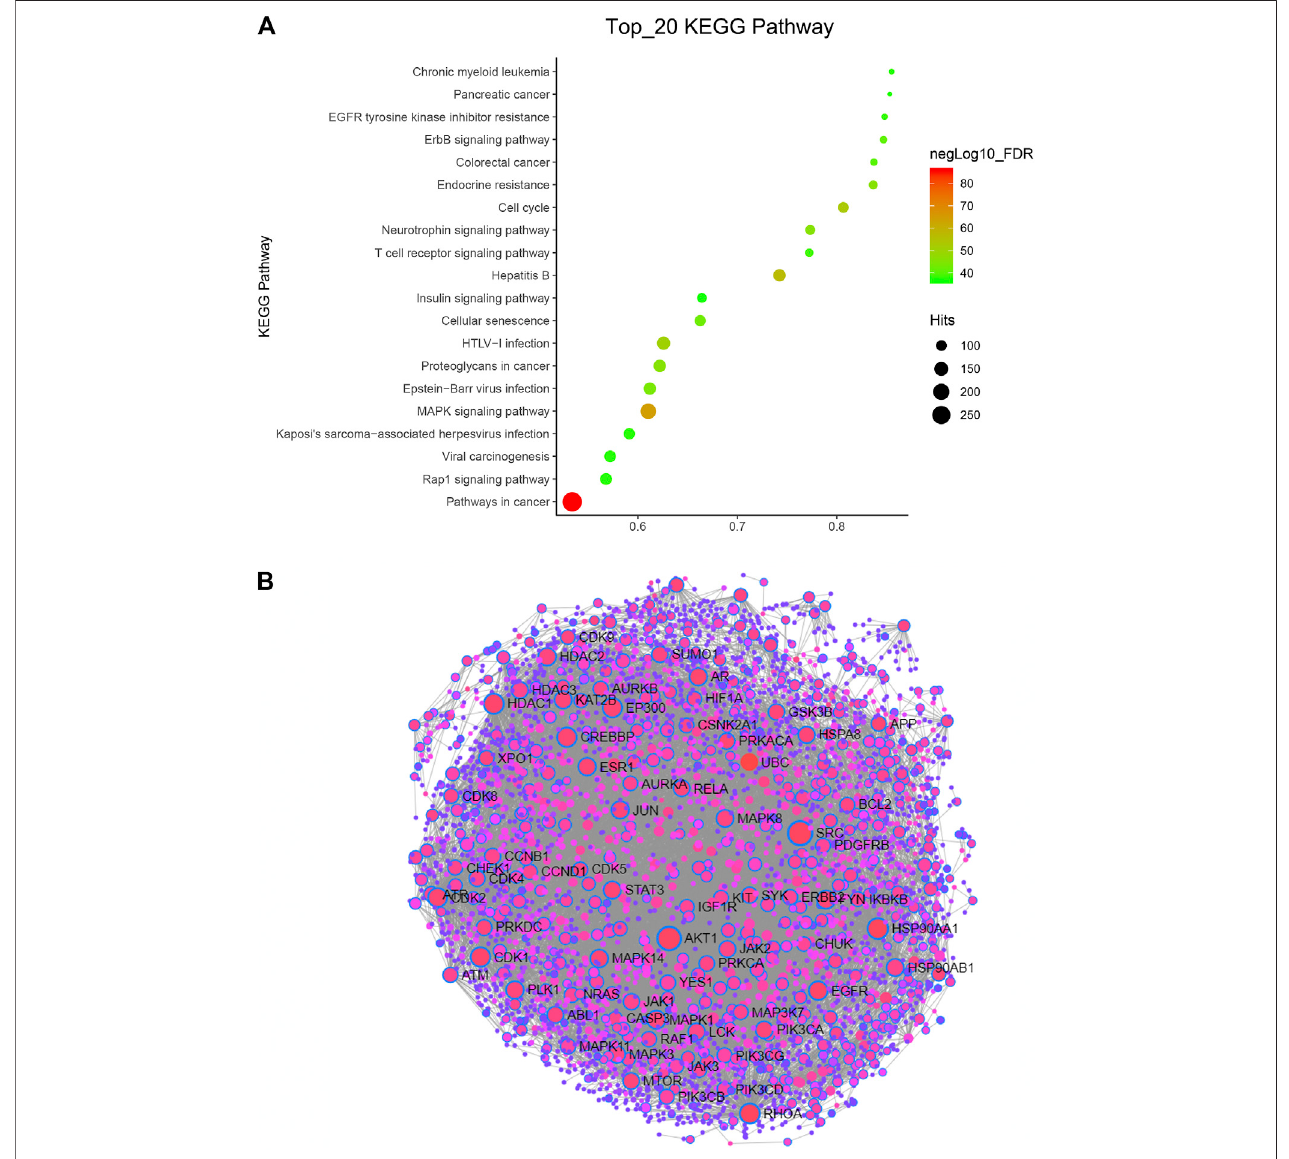
FIGURE 2 | KEGG pathway and PPI network analysis of Hansenia weberbaueriana . (A) KEGG pathway analysis. The x -axis displays as gene ratio (Hits/Total) and the y -axis represents the GO_MP/BP terms. The intensity of the color depends on the − log10(FDR) and red means a higher signi fi cant difference. The size of the point shows the number of Hits. (B) PPI analysis. The circle represents the target gene, the line represents the interaction, and the gene with the name represents the highly related target.